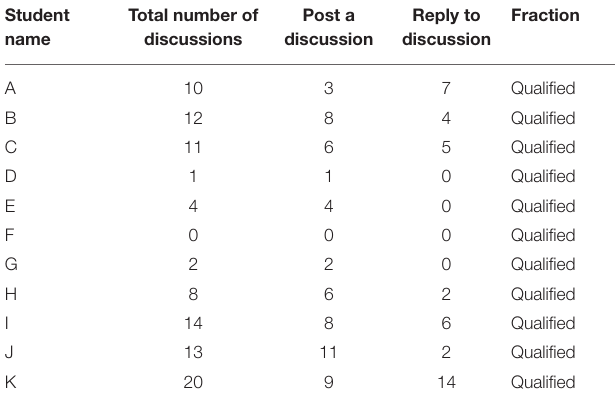
TABLE 4 | Discussions of students’ online